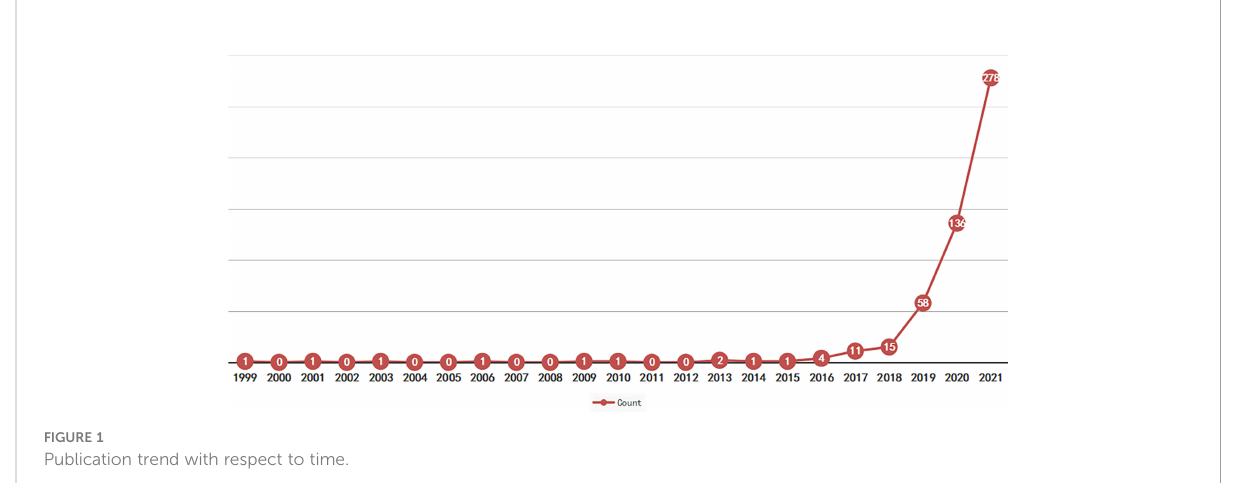
FIGURE 1 Publication trend with respect to